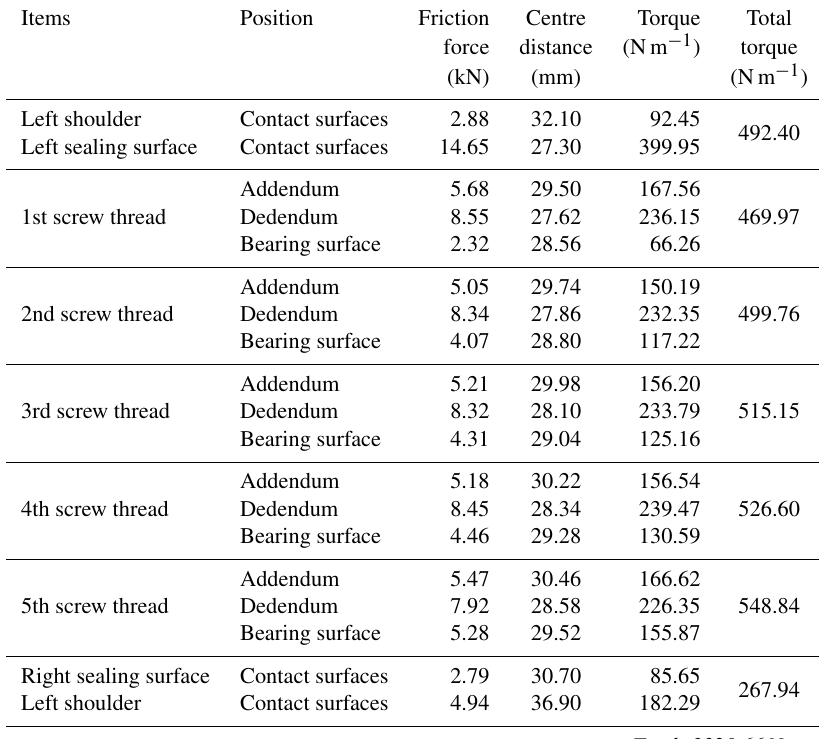
Table 3. Composition of the optimum makeup torque.